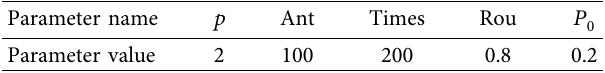
Table 3: Algorithm parameters of